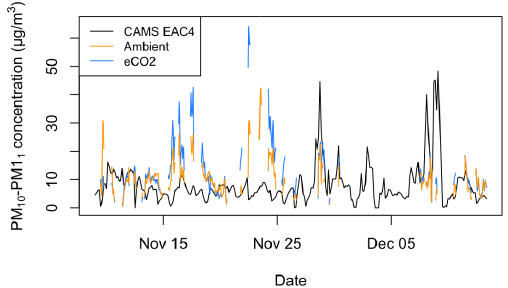
Figure 8. Time series data of the PM 10 –PM 1 mass concentrations measured in the ambient and e CO 2 arrays and provided by the Copernicus Atmosphere Monitoring Service (CAMS) global re- analysis (EAC4) dataset. The BIFoR data contain only data col- lected when RH <